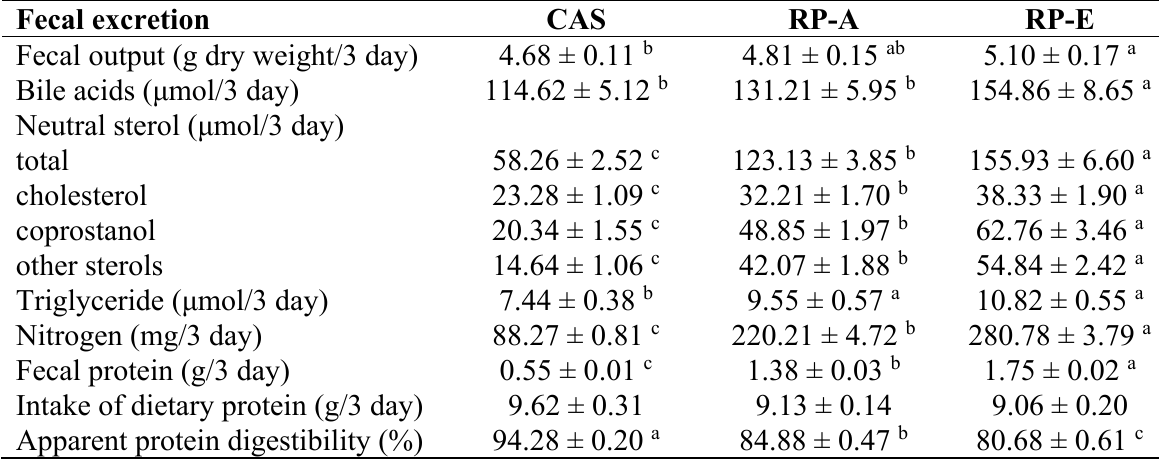
Table 6. Fecal excretion of steroid and nitrogen in rats fed experimental diets.